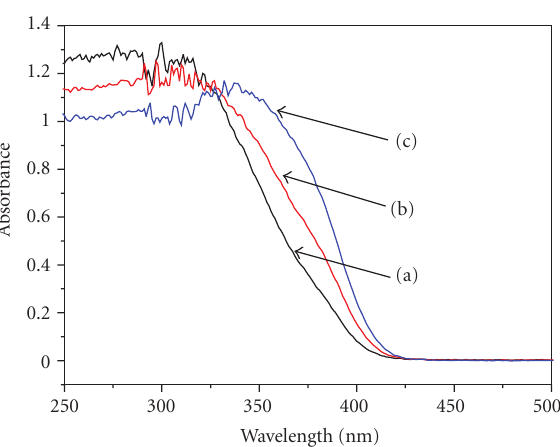
Figure 3: UV-Vis absorption spectra of P25 powders before (a) and after calcination at 500 (b), and 700 ◦ C (c) for 4h.